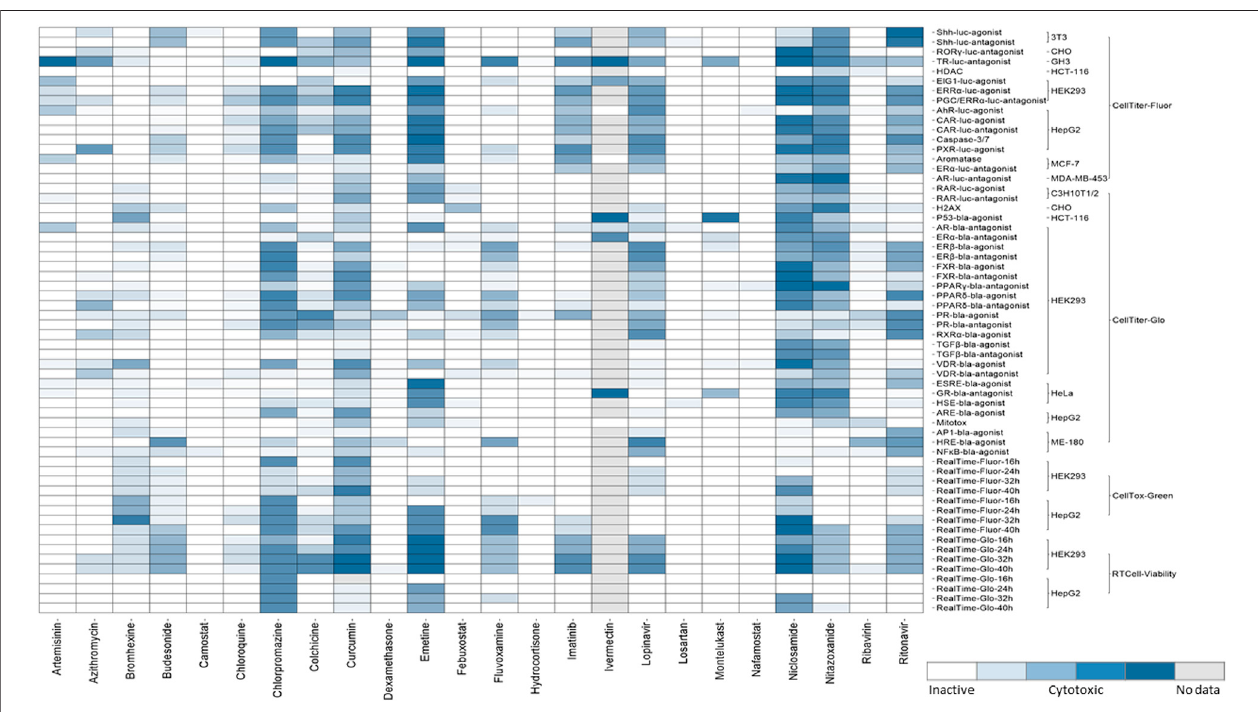
FIGURE2| CytotoxicityofthedrugsfromTox21screenings.Intheheatmap, each rowisanassayreadout and each columnisadrug.Theheatmapiscoloredby the activity. The different shades of blue indicates the cytotoxicity of the drugs in a particular assay. The cytotoxic assays performed for Tox21 screenings are grouped mainly into four categories- CellTiter-Fluor, CellTiter-Glo, CellTox-Green, and RT Cell-Viability and further subgroups are the cell types used for each assay.